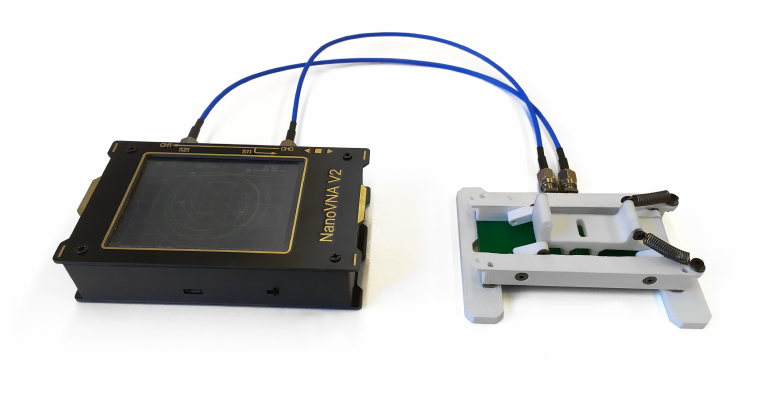
Figure 6. Pressure jig in combination with NanoVNA